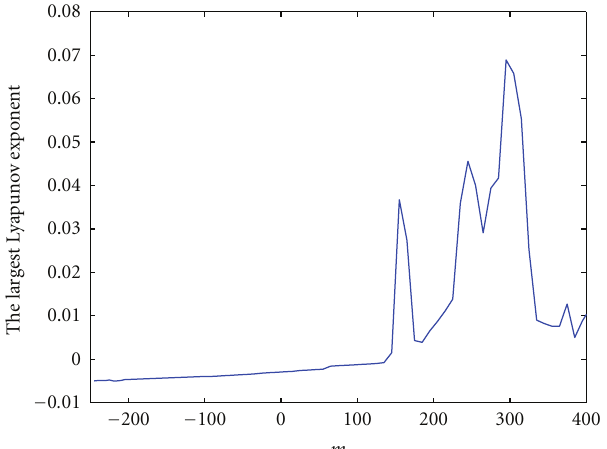
Figure 12: The relationship of the largest Lyapunov exponent (LLE) and m for k = − 10 .